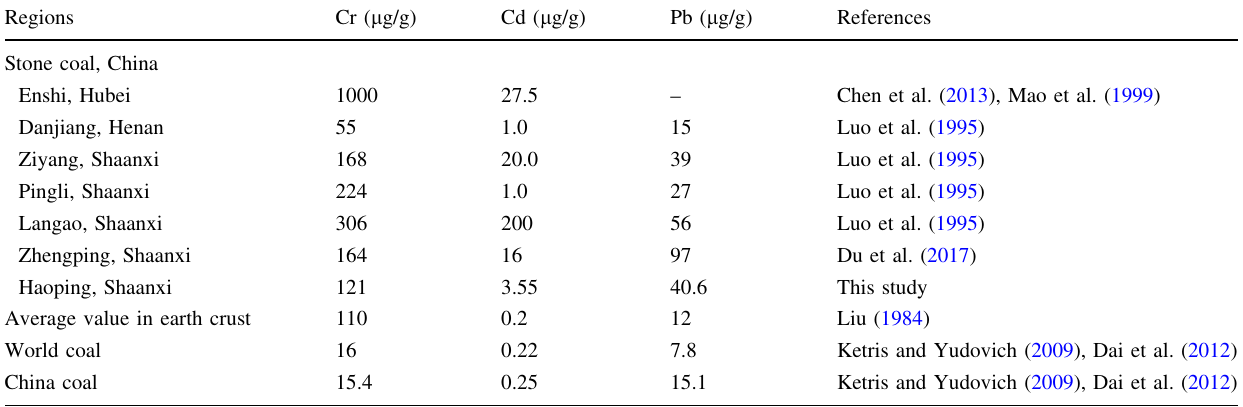
Table 2 Average contents of Cr, Cd, and Pb in raw stone coal from different regions in China (Dai et al. 2012; Ketris and Yudovich 2009; Chen et al. 2013; Luo et al. 1995; Liu 1984)